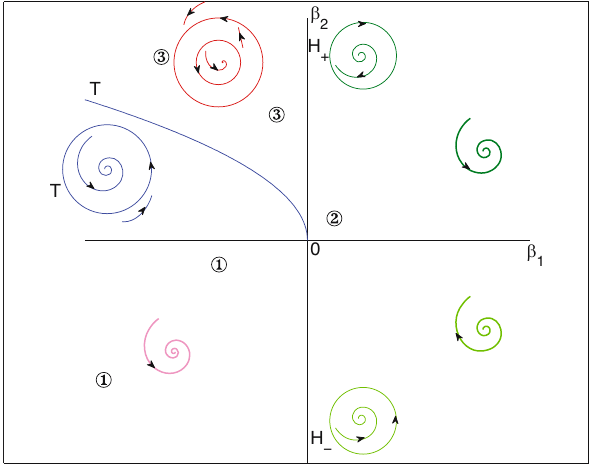
Figure 1: Around Bautin point